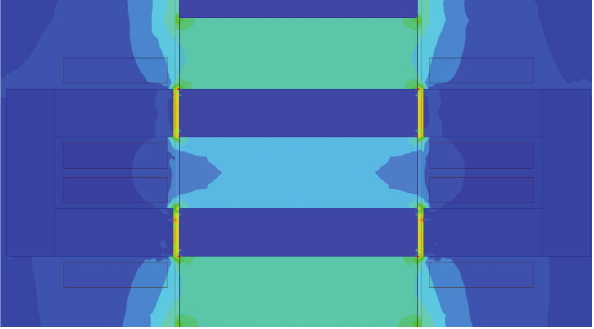
Figure 36: Magnetic field intensity at 𝑡 = 40 ms.